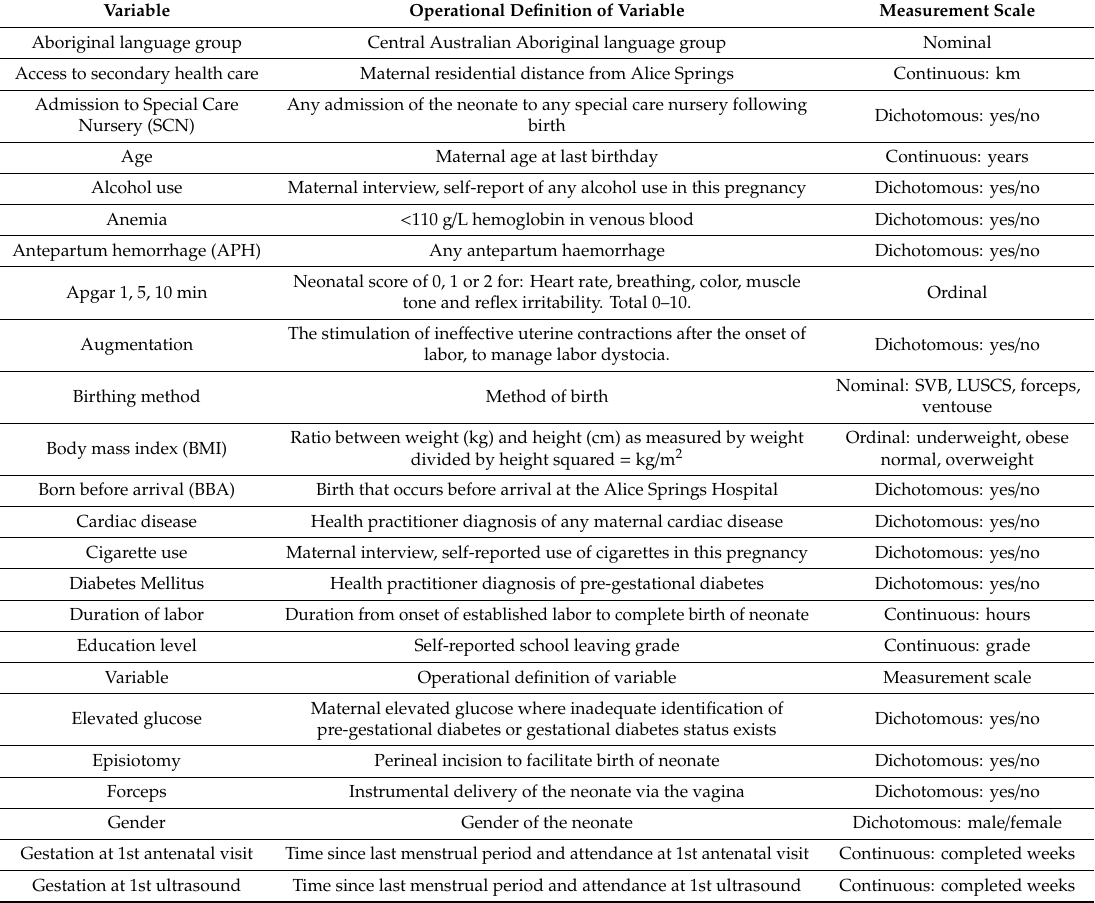
Table 2. Maternal Interview and Exposure Variables and Maternal and Perinatal Outcome Variables.